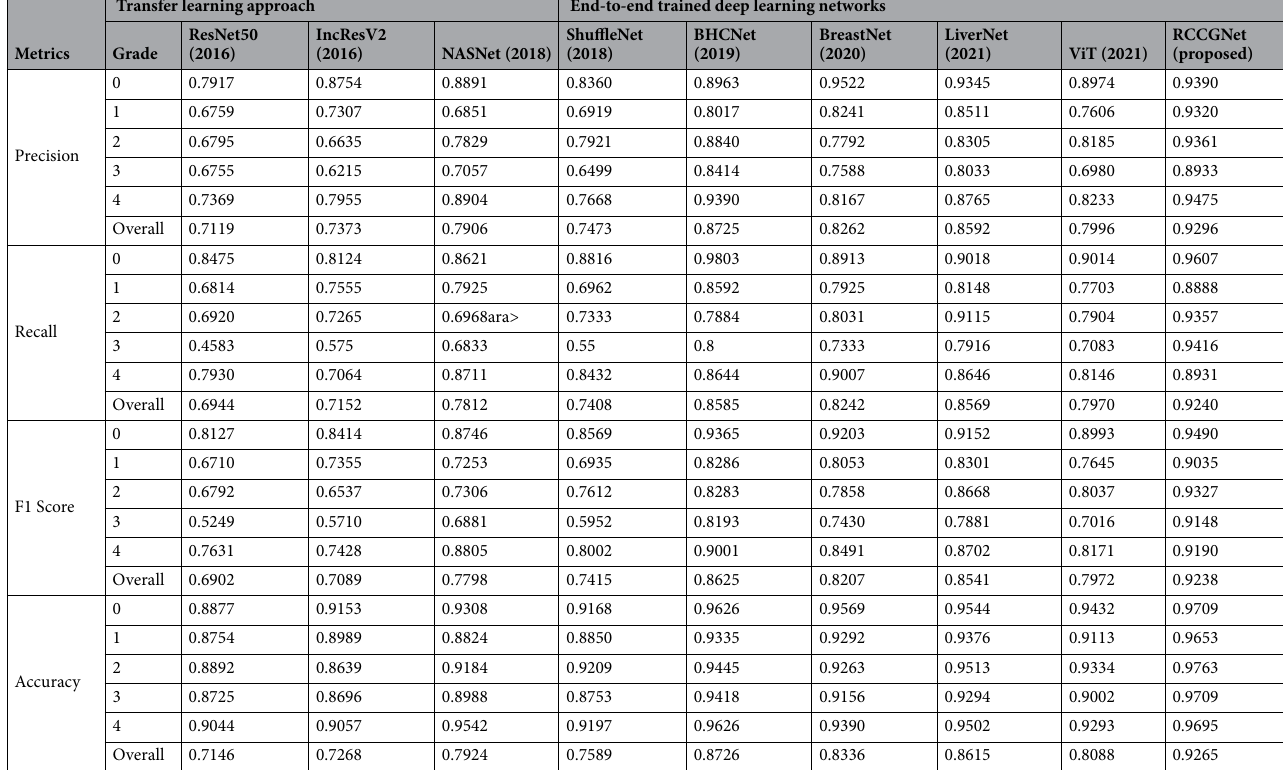
Table 6. 3-Fold cross validation average quality metrics comparison of proposed RCCGNet with other competitive models (KMC kidney